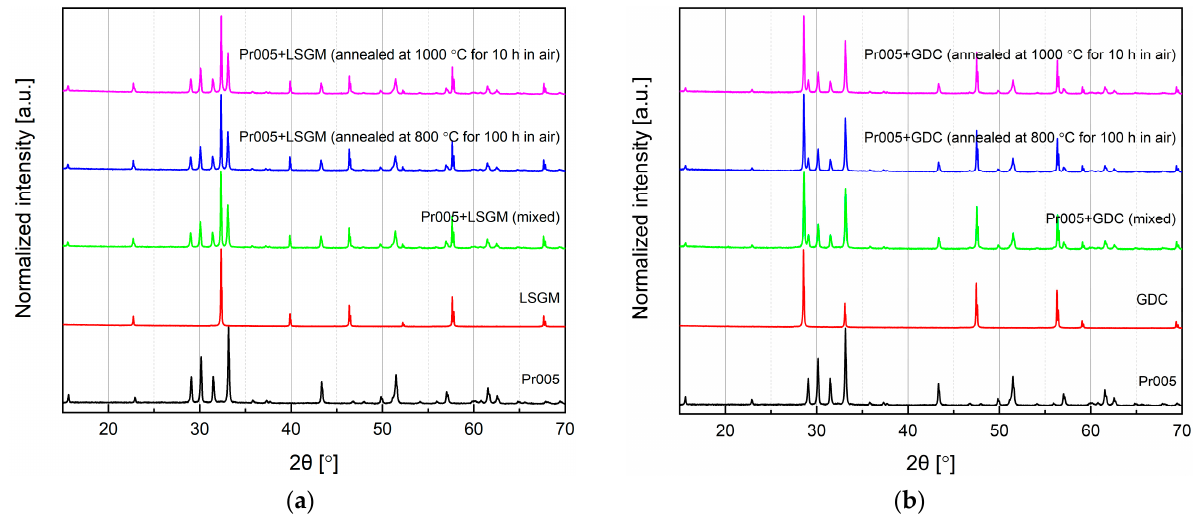
Figure 6. XRD patterns recorded in the stability experiments. Data presented for the pure and mixed samples, as well as annealed mixtures of ( a ) Pr005 and La 0.8 Sr 0.2 Ga 0.8 Mg 0.2 O 3 − d (LSGM), and ( b ) Pr005 and Ce 0.9 Gd 0.1 O 1.95 (GDC).